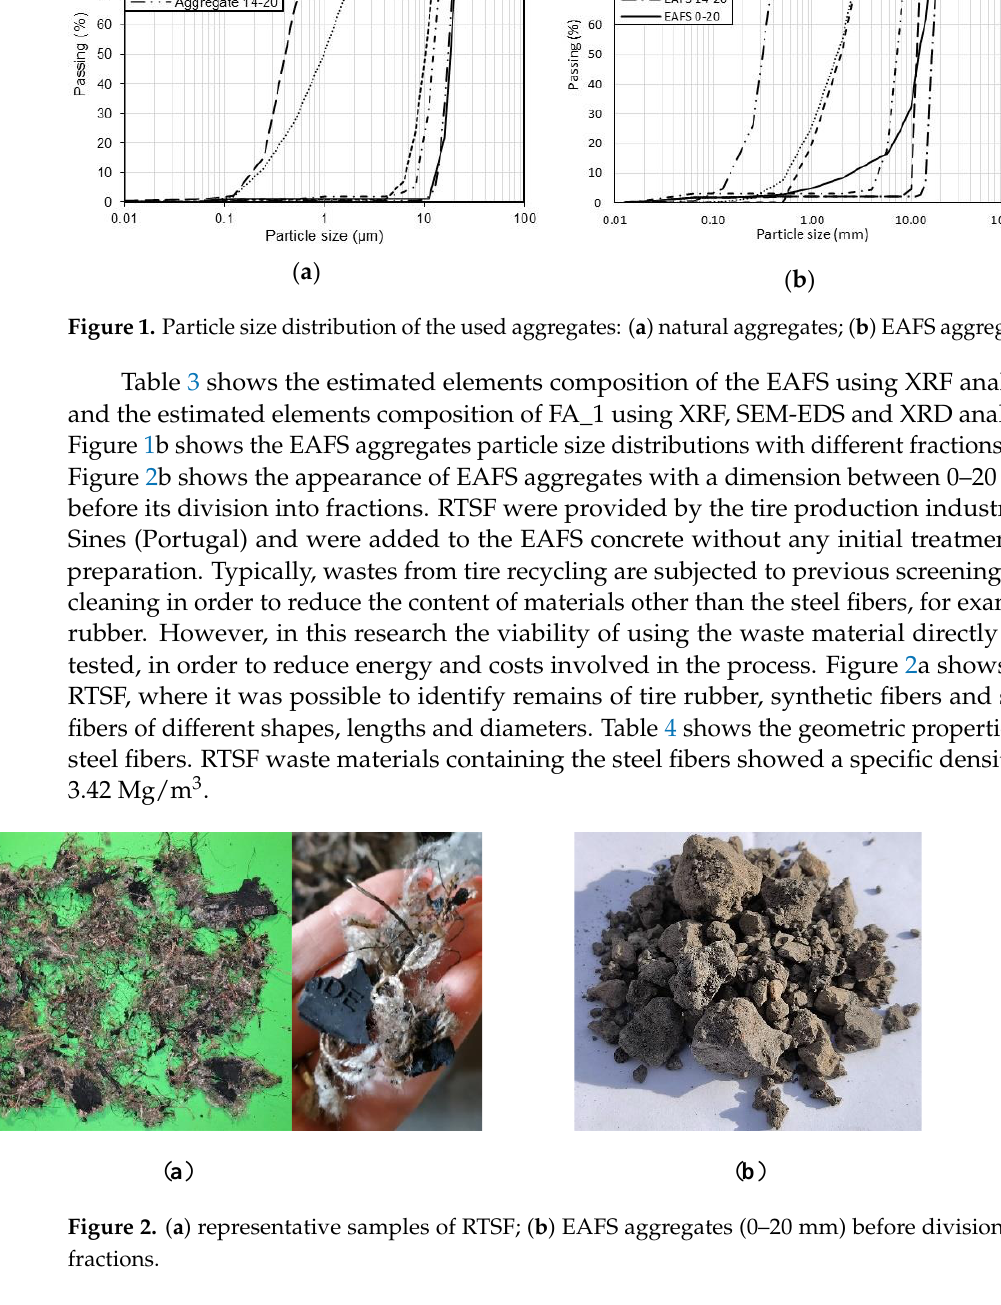
Table 1. The physical properties of EAFS grain size fractions 0–0.5 mm, 0.5–4 mm and 0–4 mm were obtained for the larger fraction, namely the grain size fraction 0–4 mm. The fractions for formulating the EAFS concrete compositions.